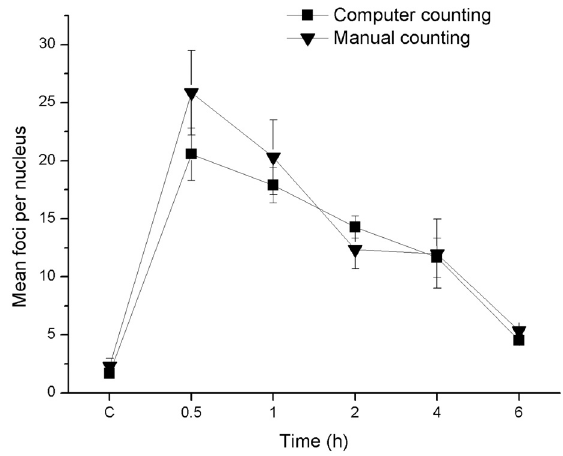
Figure 1 - Mean number of γ H2AX foci per HTB140 cell nucleus, counted by computer software (full square) or manually (full triangle), as a function of time elapsed after irradiation with 2 Gy γ -rays (C-control). Data obtained from 3 experiments are presented as mean ±